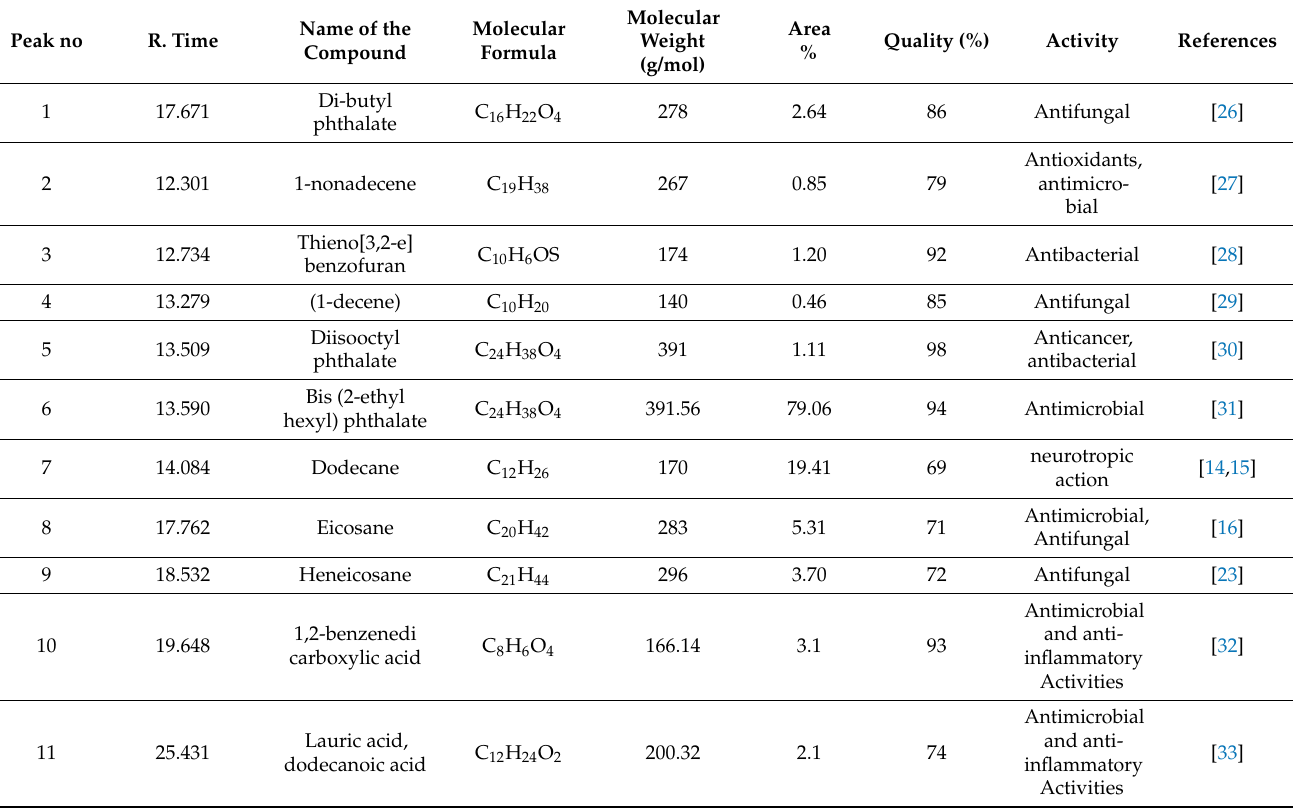
Table 3. Antimicrobial compounds identified in the ethyl acetate extract by GC-MS from fraction no. 7. Peak R. Time no